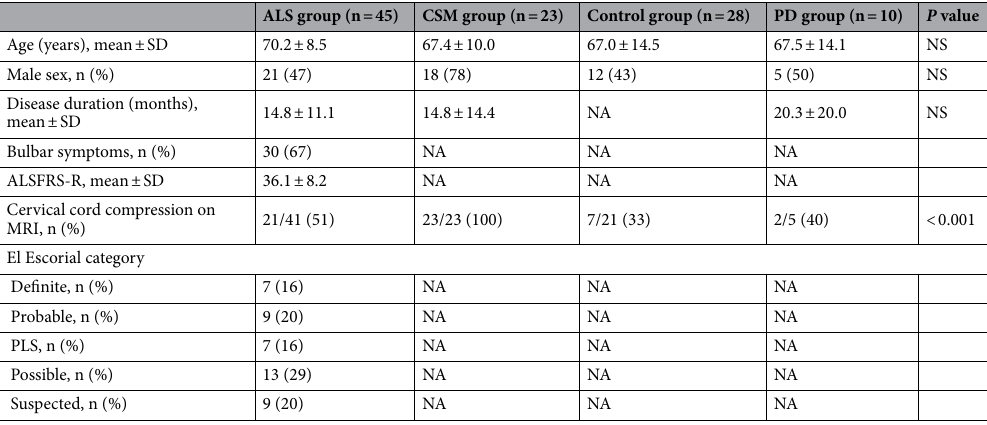
Table 1. Characteristics of the ALS, CSM, control, and PD groups at the time of CSF sampling. ALS amyotrophic lateral sclerosis, ALSFRS-R revised ALS functional rating scale, CSF cerebrospinal fluid, CSM cervical spondylotic myelopathy, NA not applicable, NS not significant, PD Parkinson’s disease, PLS probable